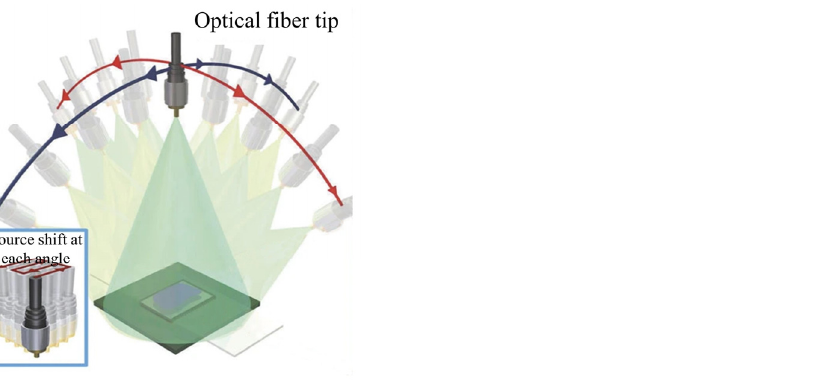
Figure 20. Super-resolution lens-less microscopy based on multi-angle scanning [122].